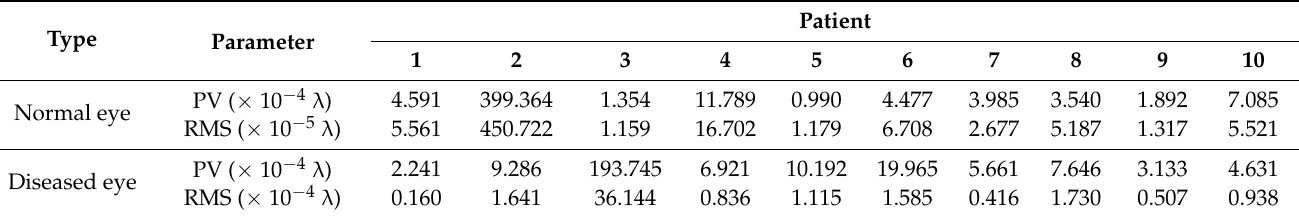
Figure 8. Performance of optimized vSHWS used for clinical ocular aberrations. ( a ) Wavefront error and ( b ) coefficient errors obtained with a set of normal eye’s aberrations; ( c ) statistical coefficient errors for 10 normal eyes; ( d ) wavefront error and ( e ) coefficient errors obtained with a set of diseased eye’s aberrations; ( f ) statistical coefficient errors for 10 diseased eyes. Table 1. RMSs and PVs of the wavefront errors obtained by using clinical human ocular aberrations (data for calculations Appendix